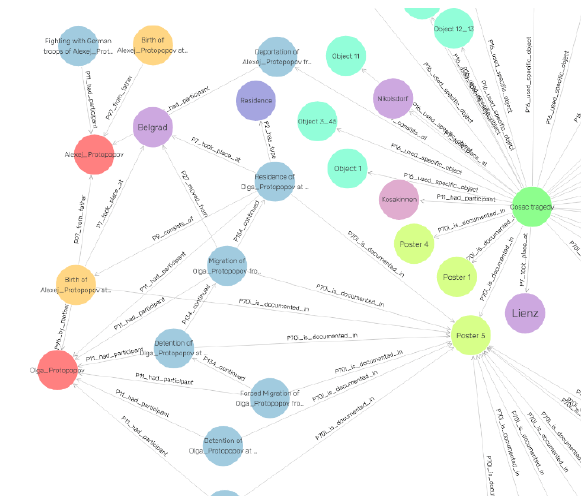
Figure 5. Visualization of a small part of the knowledge graph “ The advantage of expressing information in the W3C standard RDF is that it can be machine-processed and en- able Linked Data based discovery and access to content ” (Geser and Niccolucci 2013, p.